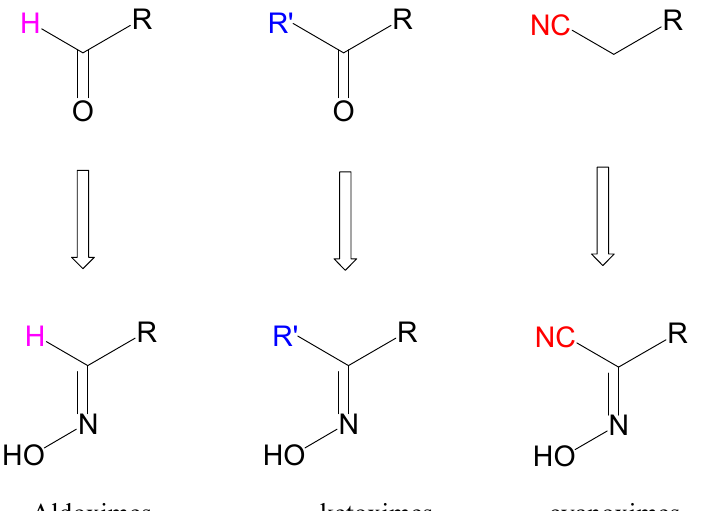
Figure 1. The relationship between different classes of oximes and their